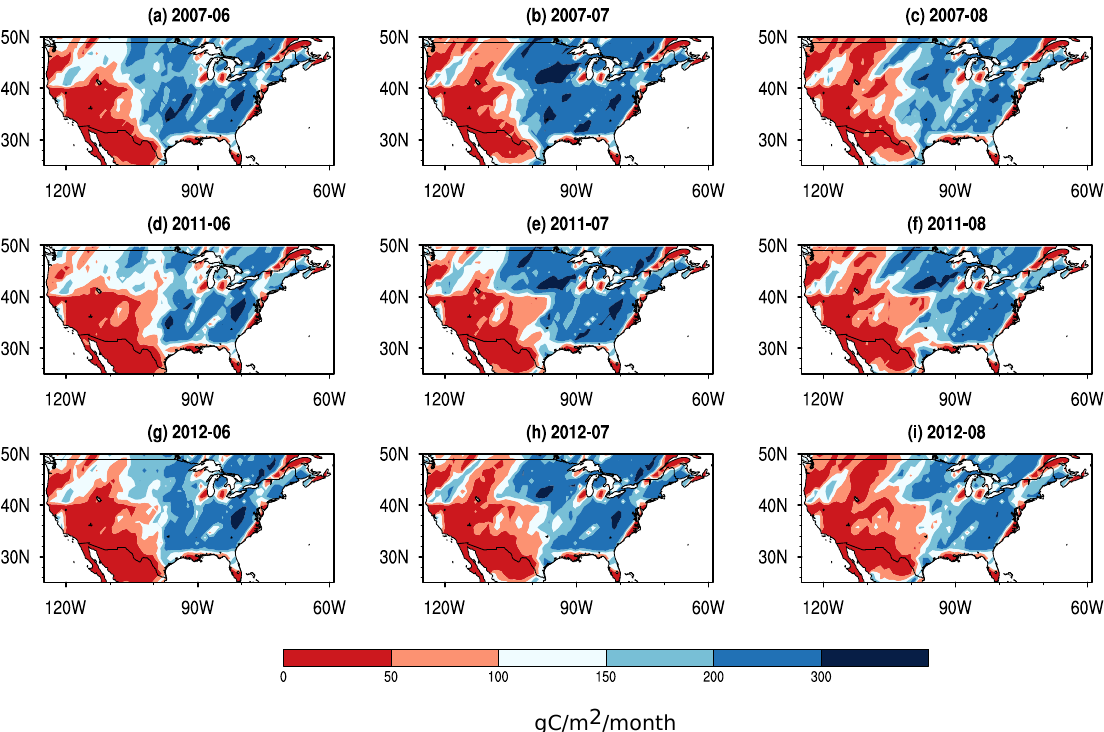
Figure 14. Gross primary production (gC/m 2 /month) from BESS data product in summer 2007 ( a – c ), summer 2011 ( d – f ), and summer 2012 ( g – i ).